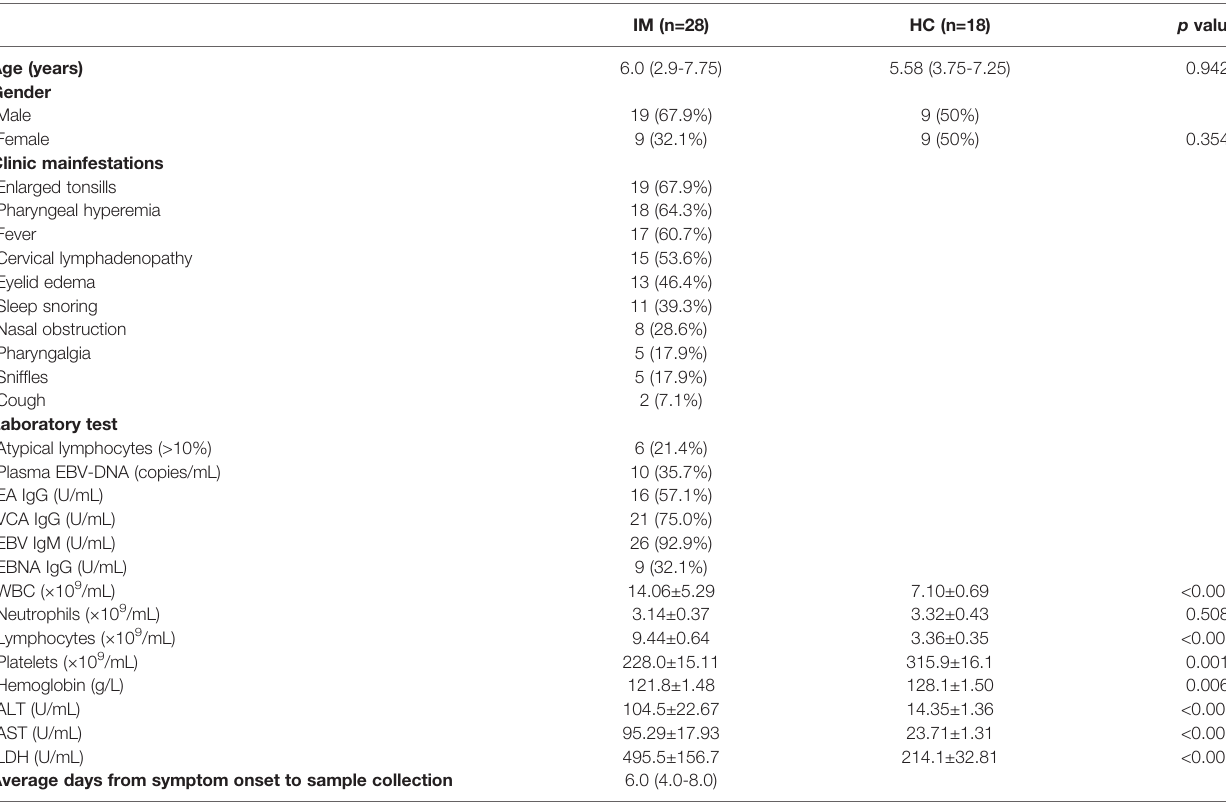
TABLE 1 | Basic characteristics of pediatric patients with infectious